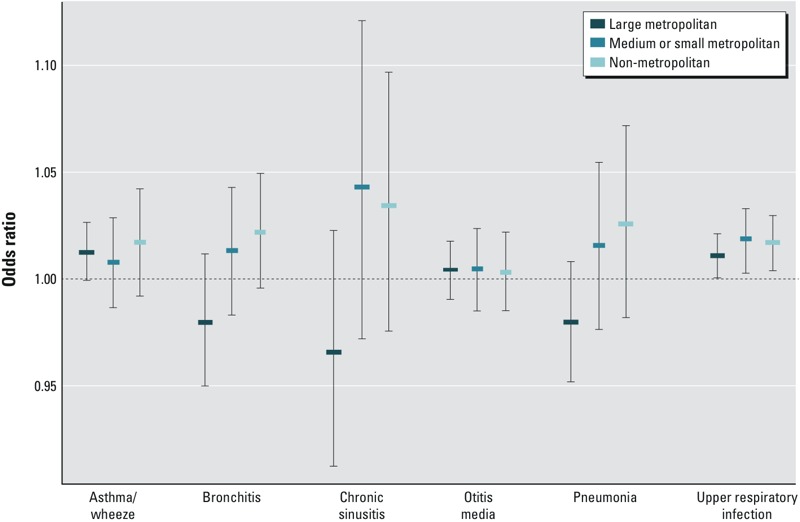
Odds ratios per 10-μg/m3 increase in same-day PM2.5 concentrations and ED visits for six pediatric health outcomes in Georgia, 1 January 2002–30 June 2010, stratified by county-level urbanicity. Odds ratios were estimated from a conditional logistic regression model with stratification by ZIP code, year, and month and with parametric control for lag 0 mean temperature, lag 0 mean humidity, and day of year using cubic polynomials; indicators for day of week, warm season, holiday, and lag holiday; and product terms between the warm season indicator and the temperature cubic polynomial, humidity cubic polynomial, day of week indicators, holiday indicators, and lag holiday indicators. Analyses were restricted to days when a ZIP code had ≥ 30% nonmissing 1-km PM2.5 estimates. ZIP code urbanicity classifications based on Ingram and Franco (2012) county-level population designations: “large metropolitan” (metropolitan counties with > 1 million residents), “medium or small metropolitan” (metropolitan counties with 250,000–999,999 residents or < 250,000 residents, respectively), and “nonmetropolitan” (counties not in a metropolitan statistical area).